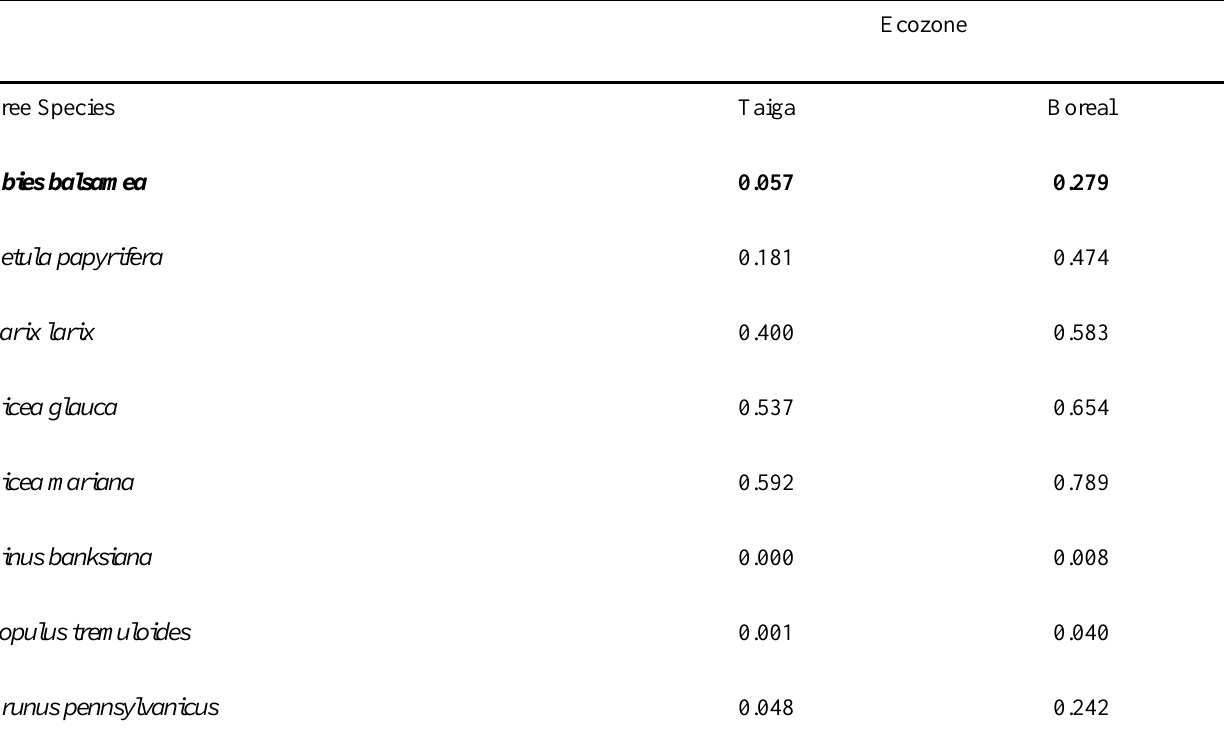
Table A1. Establishment probabilities required as input for LANDIS-II for eight tree species in Labrador planning District 19A, as estimated using LINKAGES, a forest gap-scaled ecosystem model. Discrepancies with the establishment probabilities for balsam fir (in bold) identified by provincial foresters led to recognition that finer-scaled soils data are required to accurately simulate successional trends in